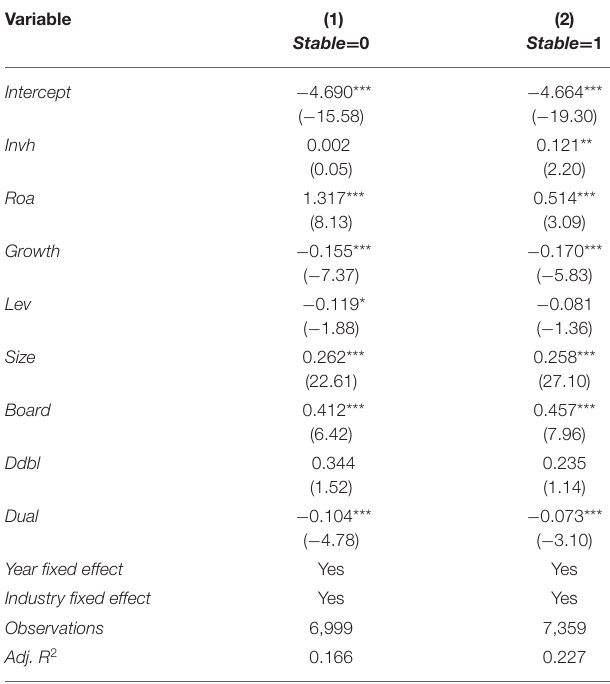
TABLE 11 | Shareholding ratio of institutional investors and environmental information disclosure quality: unstable group and stable group test.